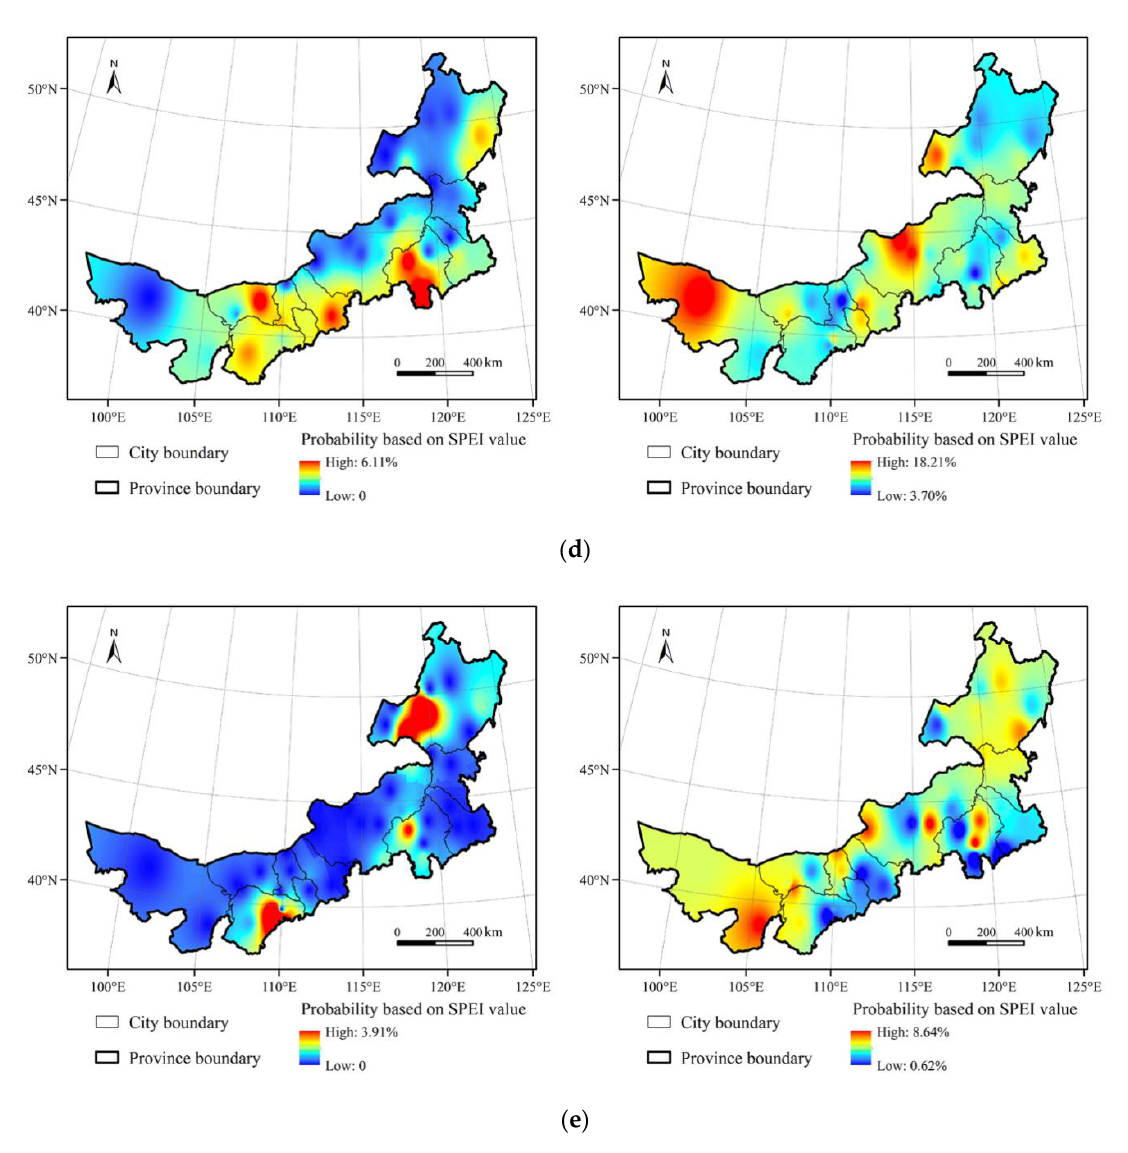
Figure 13. The spatial distribution of (a) drought, (b) mild drought, (c) moderate drought, (d) severe drought, and (e) extreme drought, in 1958 – 1992 (left-hand side), and 1993 – 2019 (right-hand side).